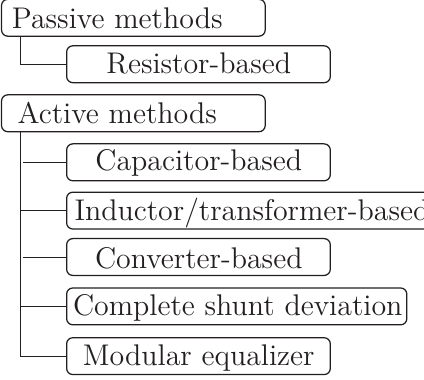
Figure 1. Classification of the